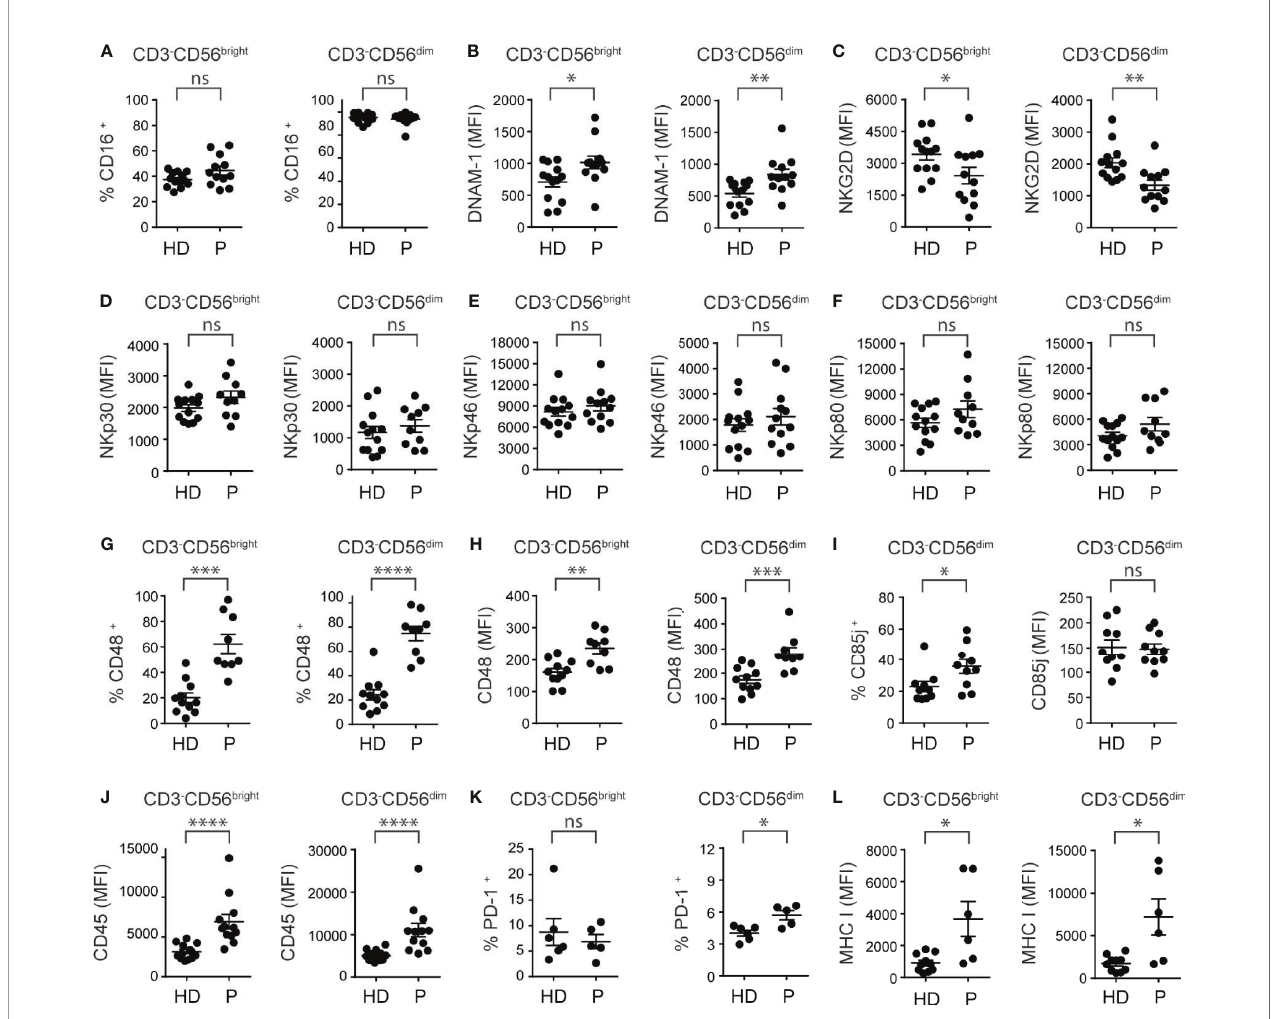
FIGURE 2 | PBNK from ccRCC patients exhibit an altered phenotype characterized by a dysregulation in the expression of activating and inhibitory receptors. PBNK cells from healthy donors (HD) and ccRCC patients (P) were analyzed by FC to compare, in the CD3 - CD56 bright ( left graph ) and CD3 - CD56 dim cells ( right graph ) subsets, the frequency of cells that expressed CD16 (A) , the intensity of expression of DNAM-1 (B) , NKG2D (C) , NKp30 (D) , NKp46 (E) , NKp80 (F) , the frequency of cells that expressed CD48 (G) , and the intensity of expression of CD48 (H) . Also, we analyzed the frequency of CD85j + cells ( left graph ) and the intensity of expression of CD85j ( right graph ) in CD3 - CD56 dim cells (I) . In addition, in CD3 - CD56 bright ( left graph ) and CD3 - CD56 dim cells ( right graph ) we analyzed the intensity of expression of CD45 (J) , the frequency of PD-1 + cells (K) , and the intensity of expression of MHC-I (L) . For HD: n =13 (A – F, J) , n =11 (G, H) , n =10 (I, L) and n =6 (K) . For P: n =12 (A – C , E, J) , n =1 (D, F, I) , n =9 (G, H) , n =5 (K) and n =6 (L) . A two-sided unpaired t-test with Welch´s correction was used in left graphs of (A – C , G, H) , in both graphs of (D – F) , and in right graph of (I) A two-sided unpaired t-test with Mann-Whitney´s correction was used in right graphs of (A – C, G, H) , in left graph of (I) and in both graphs of (J – L) . ns, not signi fi cant; * p < 0.05; ** p < 0.01; *** p < 0.001; **** p <